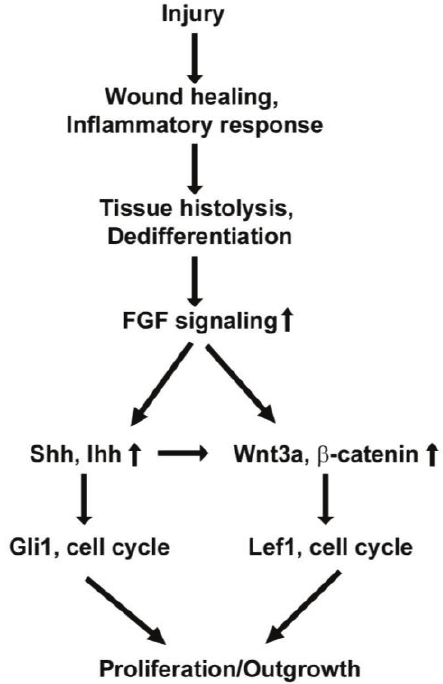
Figure 5. Hierarchical signaling pathway expression regulates regeneration. Tissue